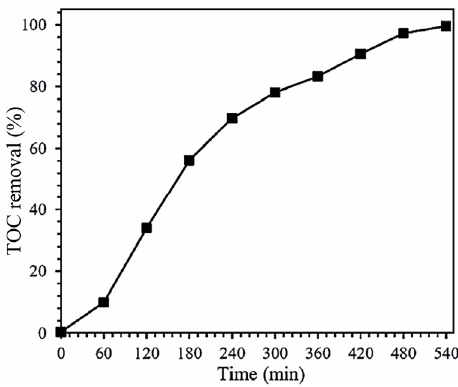
Fig. 10 TOC removal efficiency of the NTiO 2 -G photocatalyst for visible light degradation of paraoxon (to